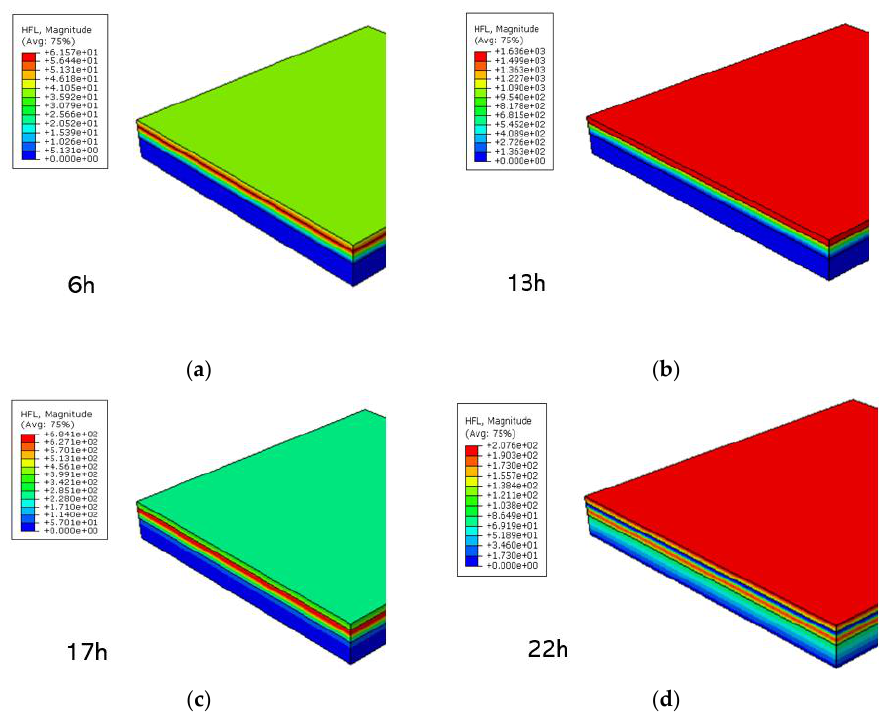
Figure 6. Cloud image of heat flux at different times in the summer: ( a ) 6 h, ( b ) 13 h, ( c ) 17 h, and ( d ) 22 h.